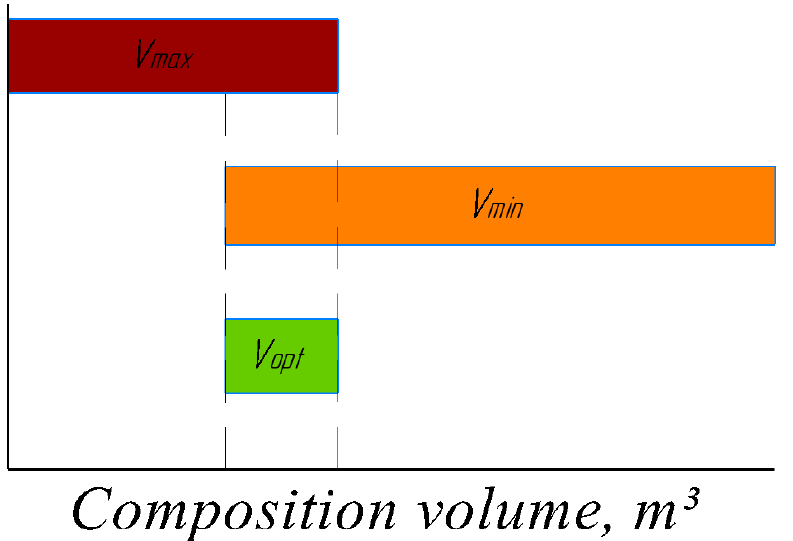
Figure 11. Determination of composition’s optimal injection volume.